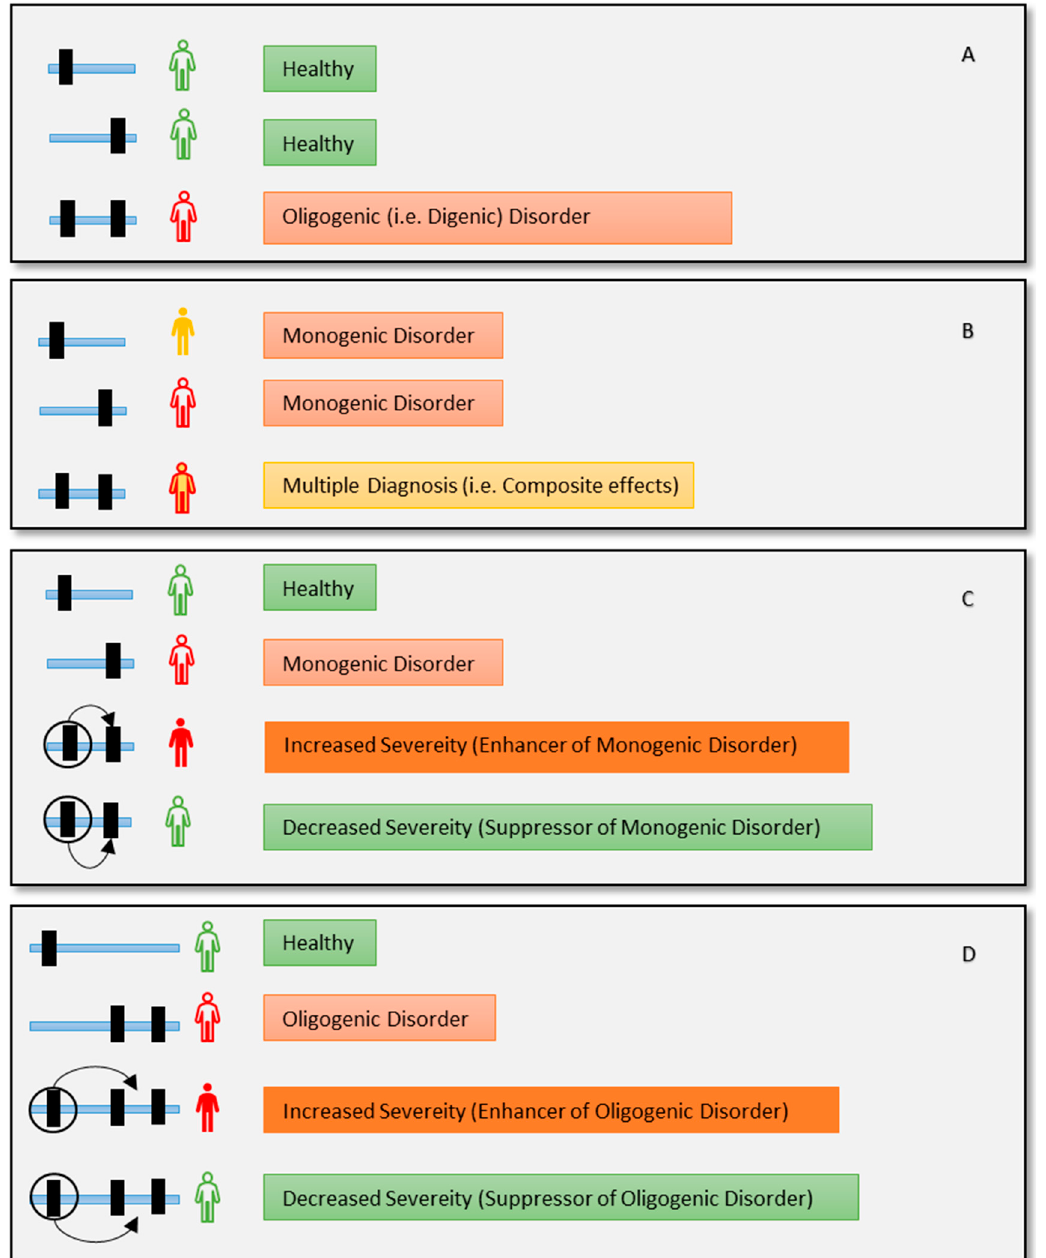
Figure 1. Different genetic phenomena in combination with Mendelian disorders, can make disease characterization challenging. ( A ) This is a case of a digenic disorder. Two individually healthy variants combinedly produce the disease (e.g., Bardet ‐ Biedl syndrome caused by BBS1 and BBS10 [35]). ( B ) Two different monogenic disorders may produce a blended or composite representation of both diseases (e.g., Mutation in NPL (causing sialic acid disorder) and GJB2 (causing deafness) creating composite disease phenotype for a patient [36]). ( C ) A case for a genetic modifier. Disease variant is modified by the modifier variant (circled) that enhances or suppresses the severity of the disease (i.e., Spinal Muscular Atrophy modified by SMN2 variants [37]). ( D ) An oligogenic disease can be modified by a modifier variant as well (i.e., Digenic Usher syndrome modified by PDZD7 [38]). More complex scenarios are also possible, such as multiple modifier alleles that can act independently or together (joint effect) [31].